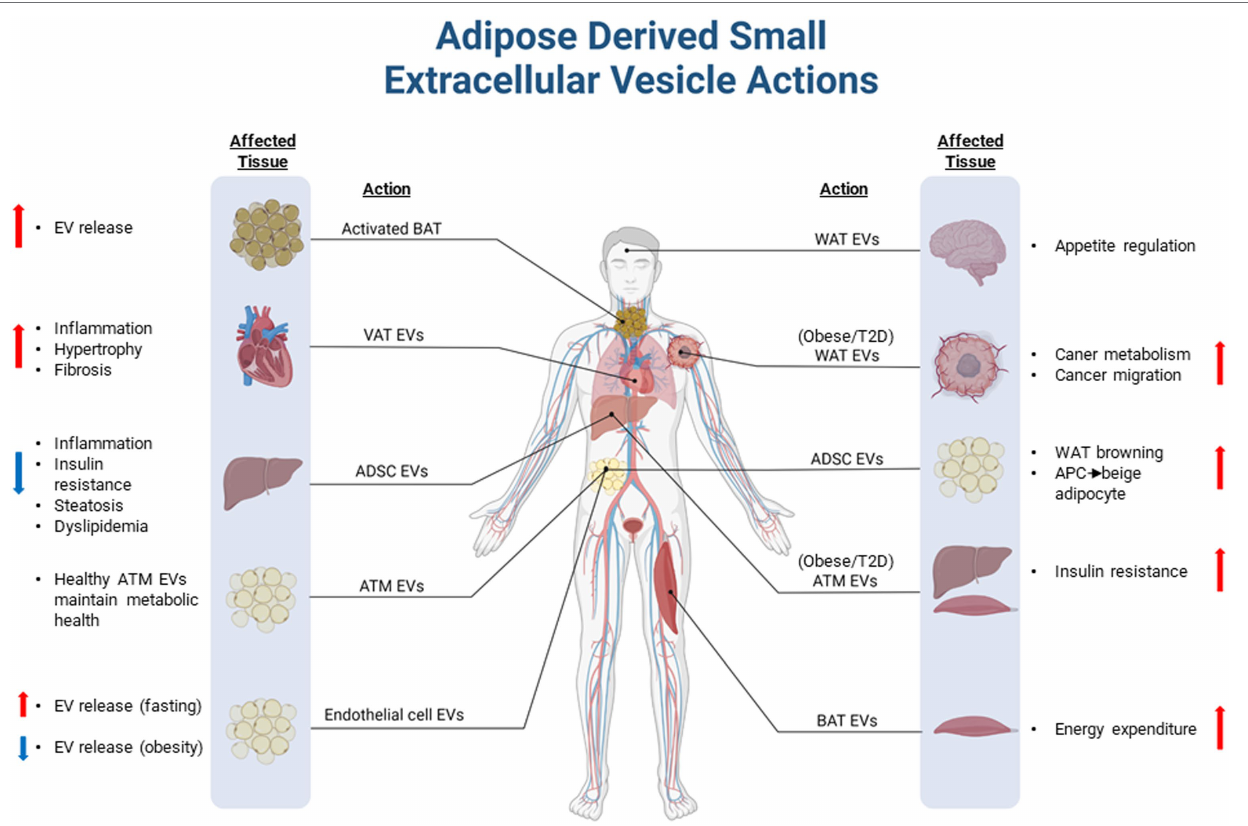
FIGURE 2 | Overview of adipose-derived small extracellular vesicles in health and disease. Extracellular vesicles (EVs) derived and released from adipose tissues can modulate physiological processes in peripheral tissues. In healthy individuals, adipose EVs may play an important endocrine and paracrine role to maintain metabolic homeostasis through reciprocal communication with peripheral tissues and other cell types residing in adipose tissue depots. EVs shed from unhealthy adipose tissue, which often occurs in diseases such as obesity and type 2 diabetes, can exacerbate or drive pathologies associated with disease complications. VAT, Visceral adipose tissue; EVs, Extracellular vesicle; ATM, Adipose tissue macrophage; WAT, White adipose tissue; BAT, Brown adipose tissue; APC, Adipocyte progenitor cell; ADSC, Adipose-derived stem cell; and T2D, Type 2 Diabetes. Figure created with